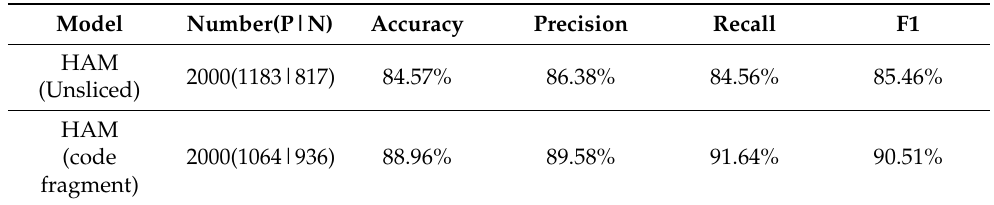
Table 4. The effect of code fragment on vulnerability